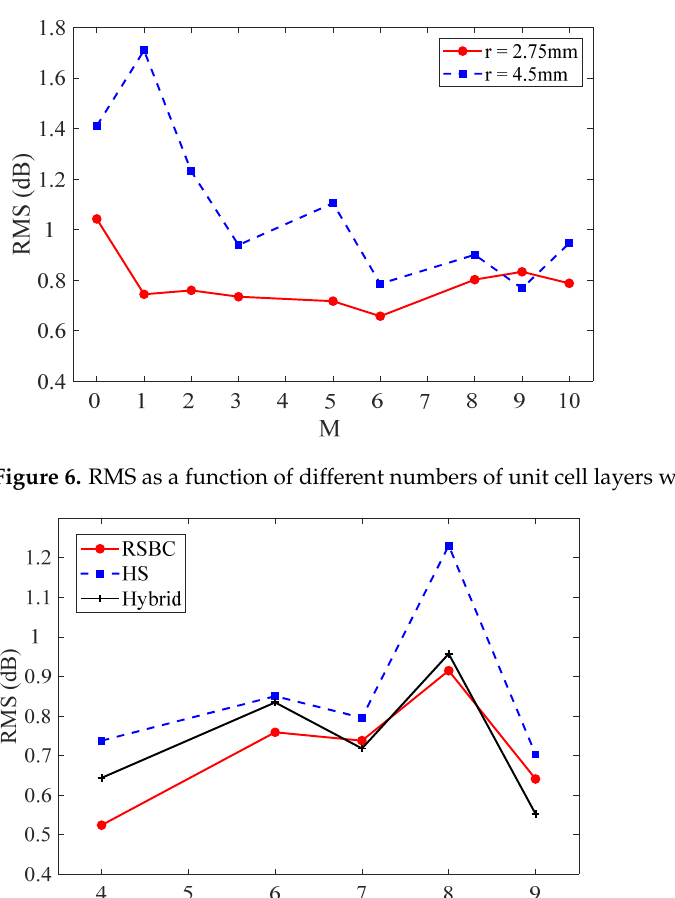
Figure 5. The hybrid model of honeycomb panel with different M values.